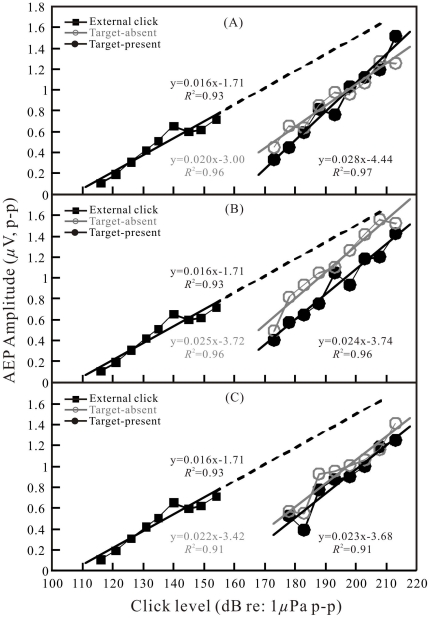
Same as in
Fig. 5
 but for the target with −34-dB target strength.